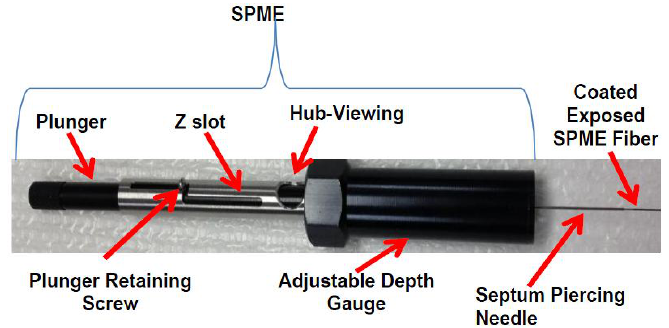
Figure 3. A variety of solid-phase microextraction fibers with different coatings used for the identification of non-polar and polar compounds, volatile odorous compounds, and/or